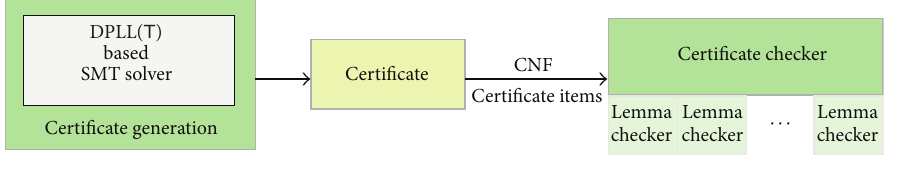
Figure 1: The road map of our